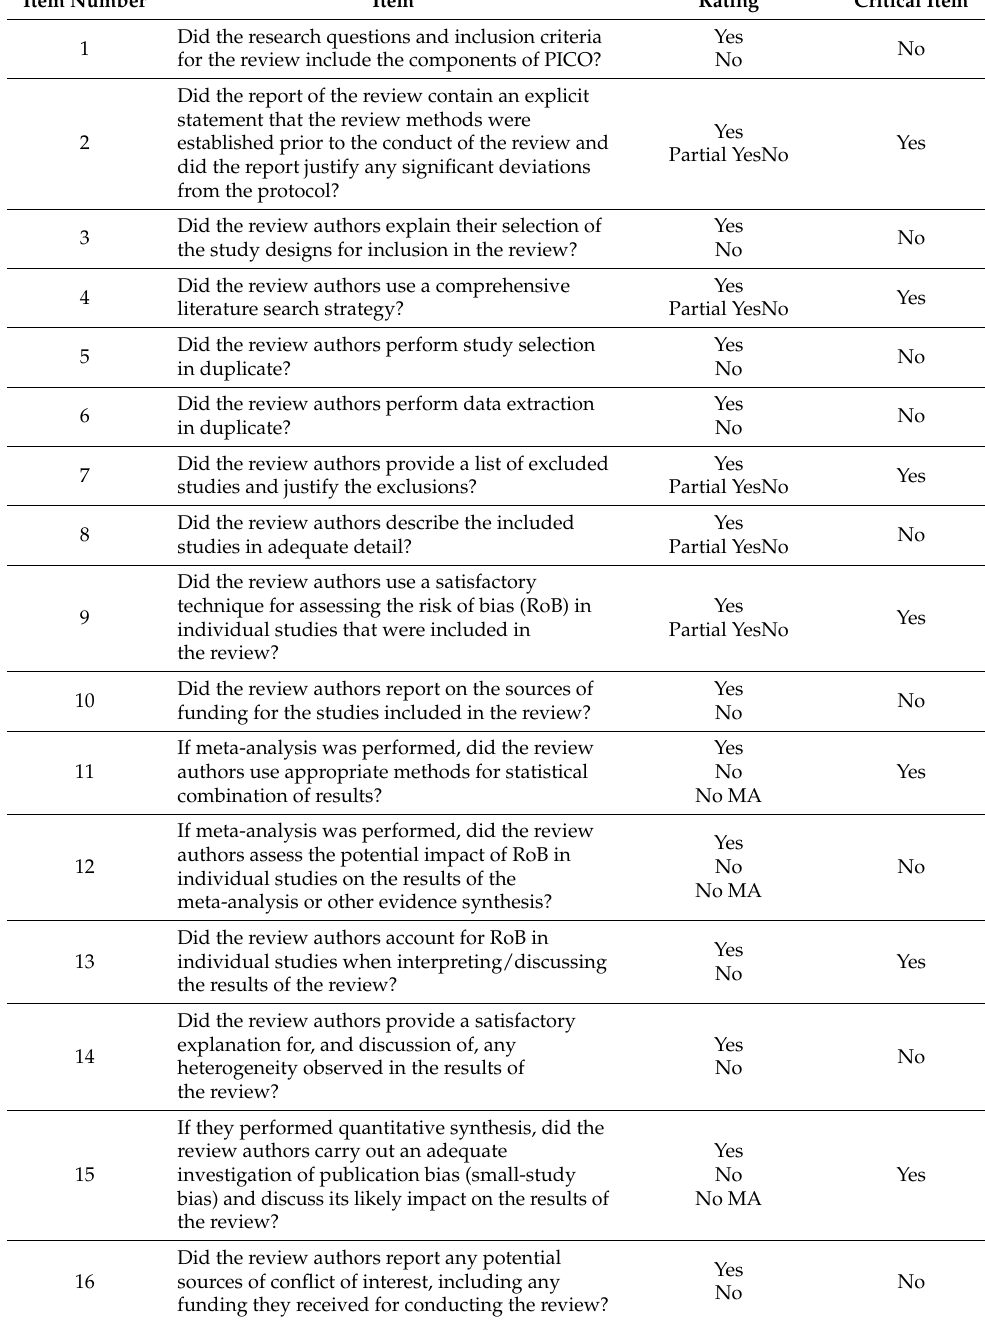
Table 1. AMSTAR 2 items